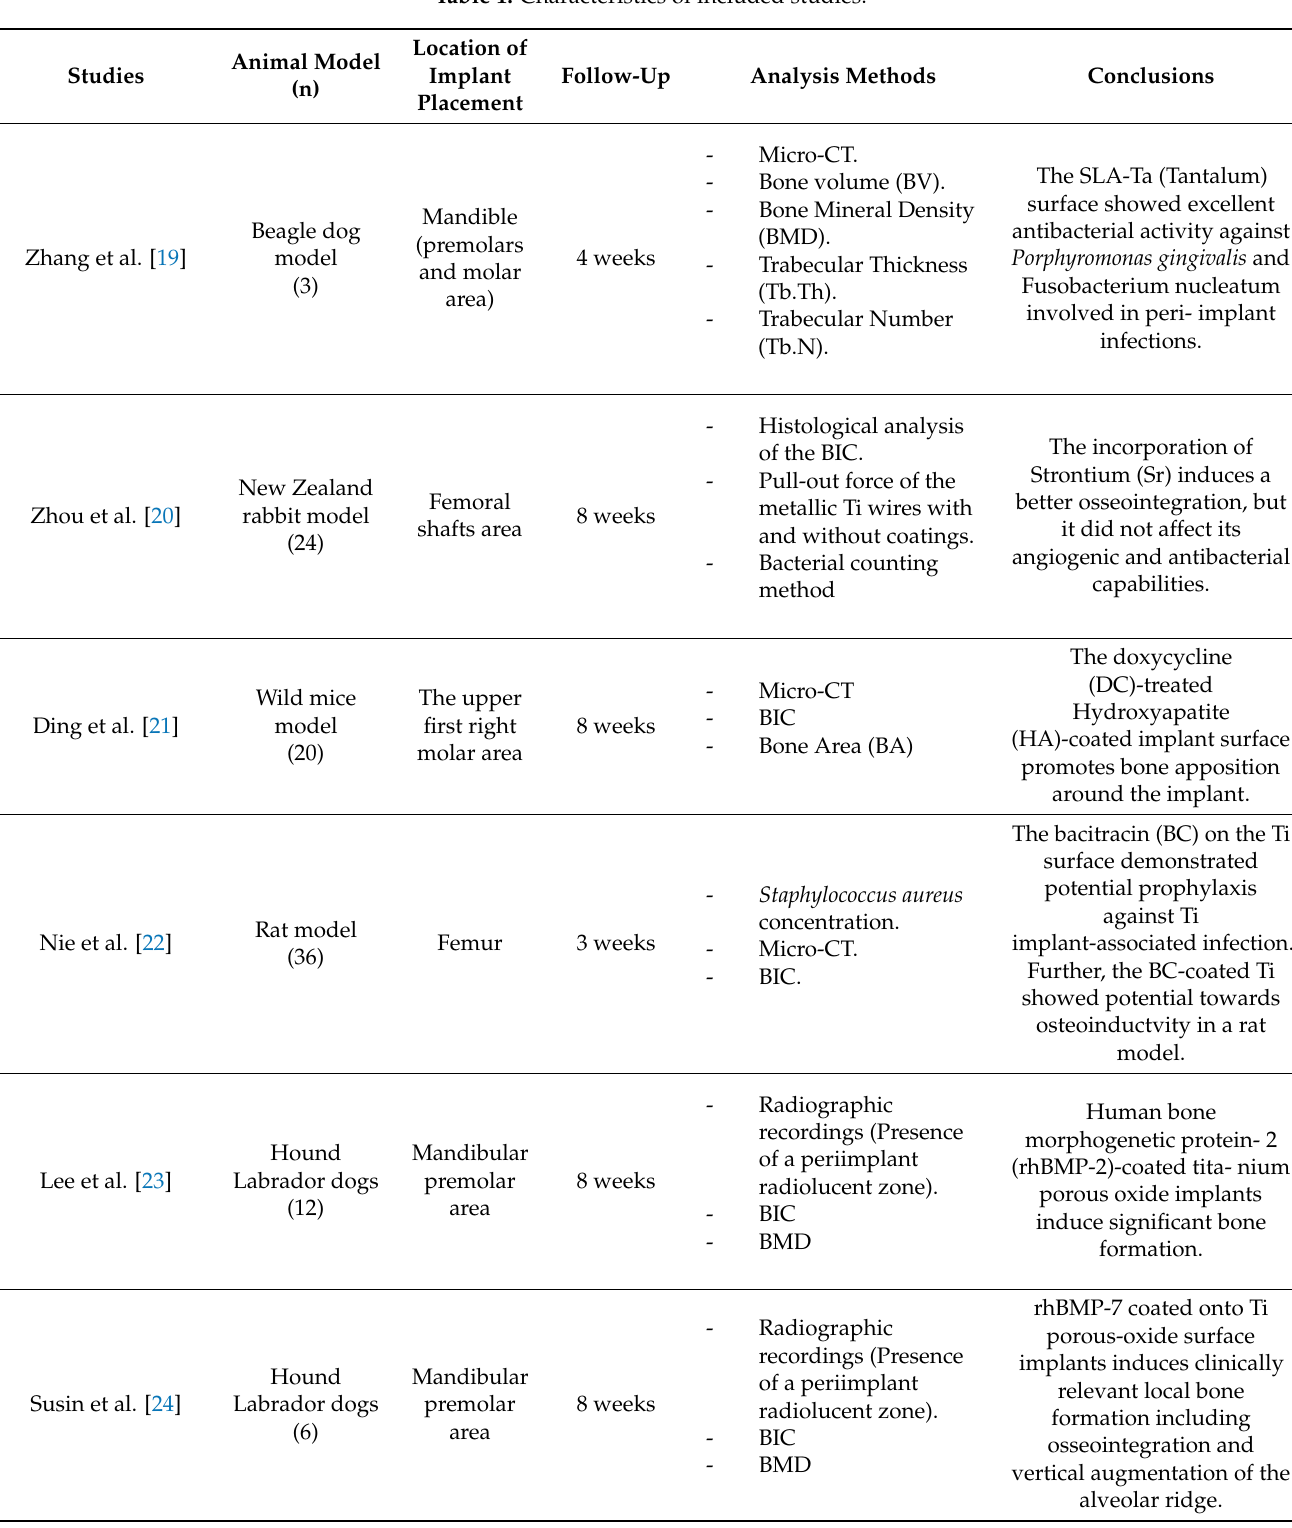
Table 1. Characteristics of included